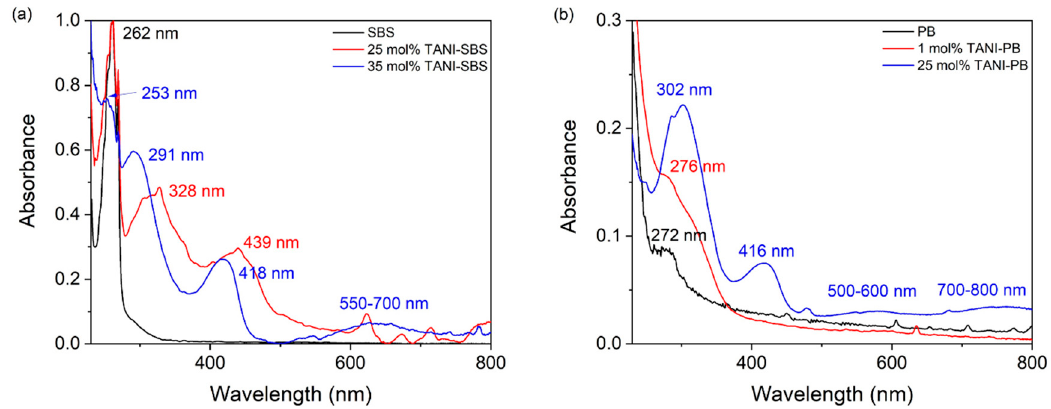
Figure 3. ( a ) UV-Vis spectroscopy of SBS, 25 mol% TANI-SBS and 35 mol% TANI SBS. ( b ) UV-Vis spectroscopy of PB, 1 mol% TANI-PB and 25 mol% TANI-PB.